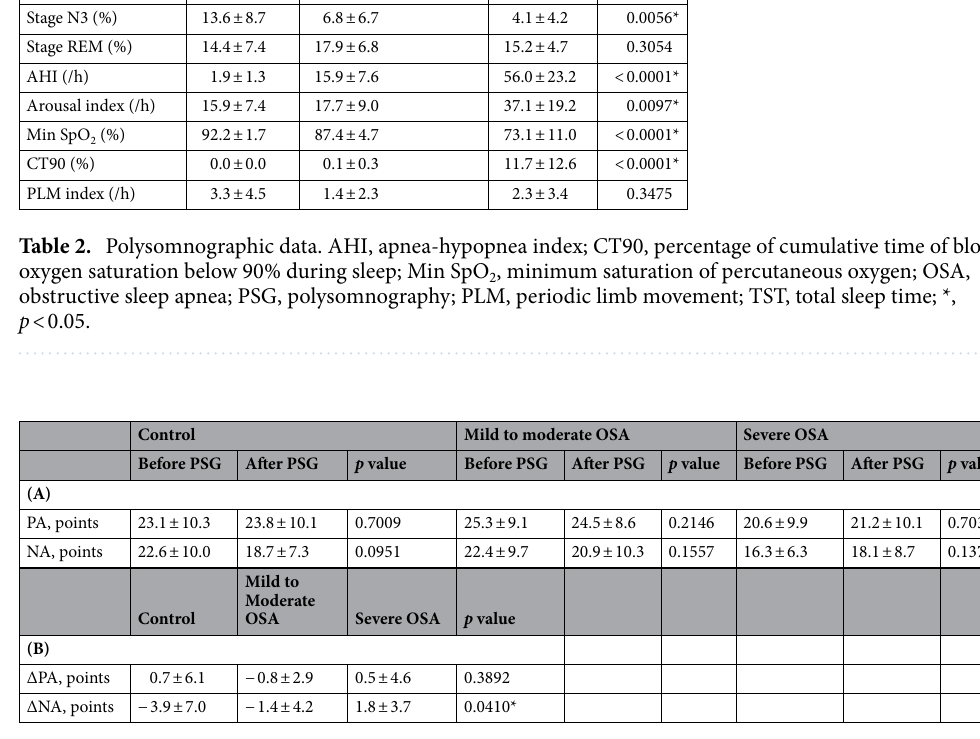
Table 3. PANAS scores immediately before and after overnight PSG. AHI, apnea–hypopnea index; NA, negative affect in the PANAS; OSA, obstructive sleep apnea; PA, positive affect in the PANAS; PANAS, positive and negative affect schedule; PSG,